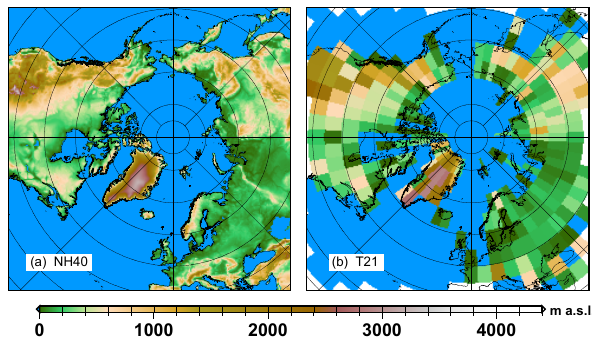
Figure 2. Northern Hemisphere topography from ETOPO1 pro- jected with a Lambert equal area on a Cartesian 40km by 40km grid (a) and in the native ECBilt grid (b) .